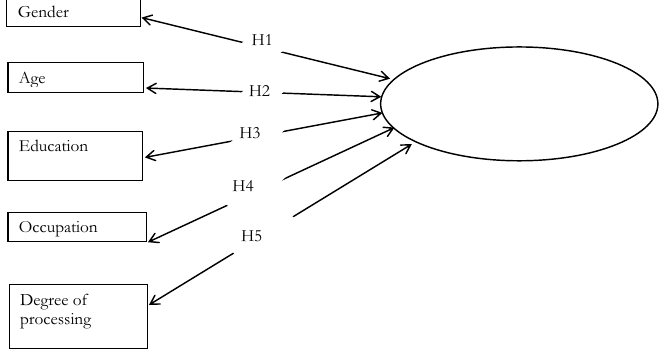
Fig. 1 - A correlation model. Sources: own research